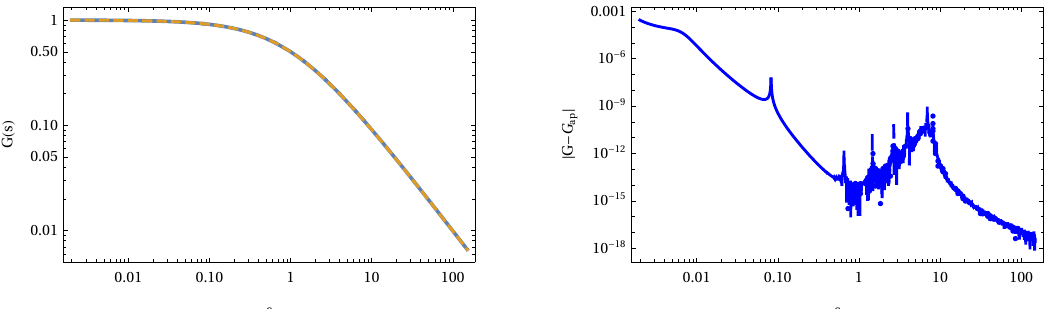
Figure 2. Approximation of the transfer function G ( s ) for the Debye relaxation equation given by (84). The left panel shows the exact transfer function G ( s ) with χ 0 = 1 and τ = 1 in connection with the approximation ˜ G ( s ) using Thiele’s algorithm (dashed line). The right panel shows the local error between the exact transfer function and its approximation. The total number of points used in the approximation is m = 2 N + 1 =